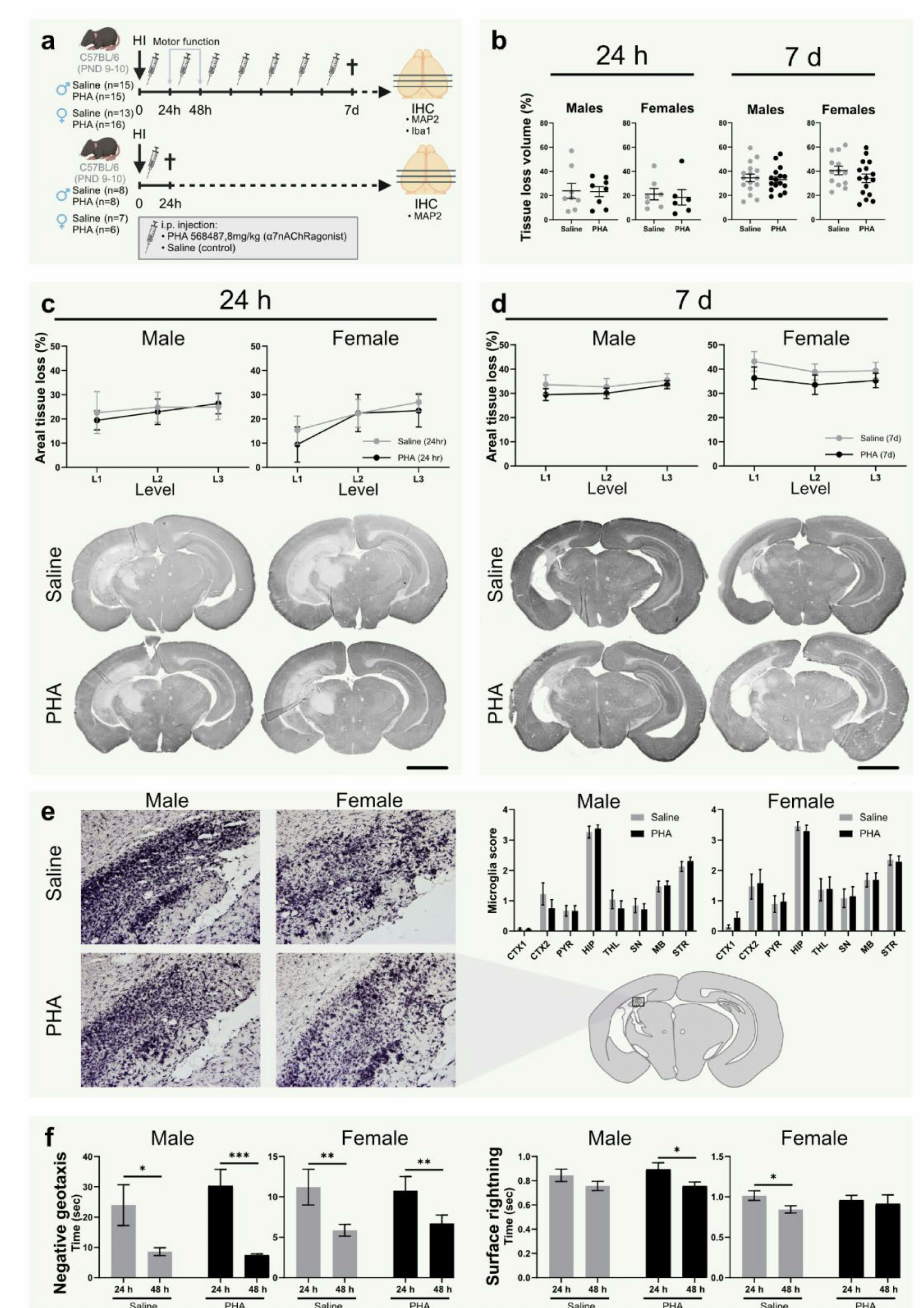
Figure 2. α 7nAChR activation does not affect tissue loss, microglial activation or motor function in neonatal hypoxic-ischemic brain injury. ( a ) Experimental timeline. Male ( left ) and female ( right ) pups were subject to hypoxia ischemia (HI) on postnatal day (PND) 9–10 and received i.p. injections once daily with either α 7nAChR agonist PHA 568487 (8 mg/kg; black) or saline (gray) until sacrifice 24 h ( n = 6–8 per group) or 7 days ( n = 13–16 per group) after HI. ( b ) Tissue loss volume (%) in the brain 24 h ( left ) and 7 d ( right ) after HI. ( c , d ) Areal tissue loss (%) at different coronal levels (caudal-rostral direction) of the brain 24 h ( c ) and 7 d ( d ) after HI. Representative micrographs (1.25 × ) of coronal sections (level 1) stained with the neuron dendrite marker MAP2. ( e ) Representative micrographs (20 × ) of hippocampus in the injured hemisphere 7 d after HI in sections (level 2) stained with the microglia/monocyte marker Iba-1. Bar graphs show microglial activation score in different regions